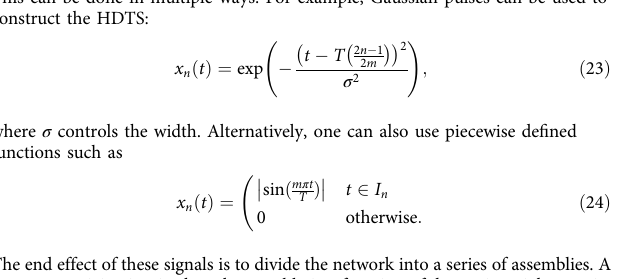
Figure 1 methods . A network of rate equations is used to learn the dynamics of a teaching signal, x ( t ), a 5 Hz sinusoidal oscillation. The network consists of 1000 rate neurons with F = 10, τ s = 10 ms, G = 1, and Q = 1.5, p = 0.1. The network is run for 1s initially, with RLS run for the next 4 s, and shut off at the 5s mark. The network is subsequently run for another 5 s to ensure learning occurs. The smooth fi ring rates of the network were less than 30Hz. The RLS parameters were taken to be Δ t = 2ms and λ − 1 = 0.5ms. Figure 2 methods . Networks of theta neurons were trained to reproduce different oscillators. The parameters were: N = 2000, G = 10 (sinusoid, sawtooth), G = 15 (Van der Pol), G = 25 (product of sinusoids), G = 15 (product of sinusoids with noise), Q = 10 4 , Δ t = 0.5ms, with an integration time step of 0.01ms. The resulting average fi ring rates for the network were 26.1 Hz (sinusoid) 29.0 Hz (sawtooth), 15.0Hz (Van der Pol relaxation), 18.8 Hz (Van der Pol Harmonic), 23.0 Hz (product of sinusoids), 21.1Hz (product of sines with noise). The Van der Pol oscillator is given by: € x ¼ μ 1 (cid:2) x 2 ð Þ _ x (cid:2) x ; for μ = 0.3 (harmonic) and μ = 5 (relaxation) and was rescaled in space to lie within [ − 1, 1] 2 and sped up in time by